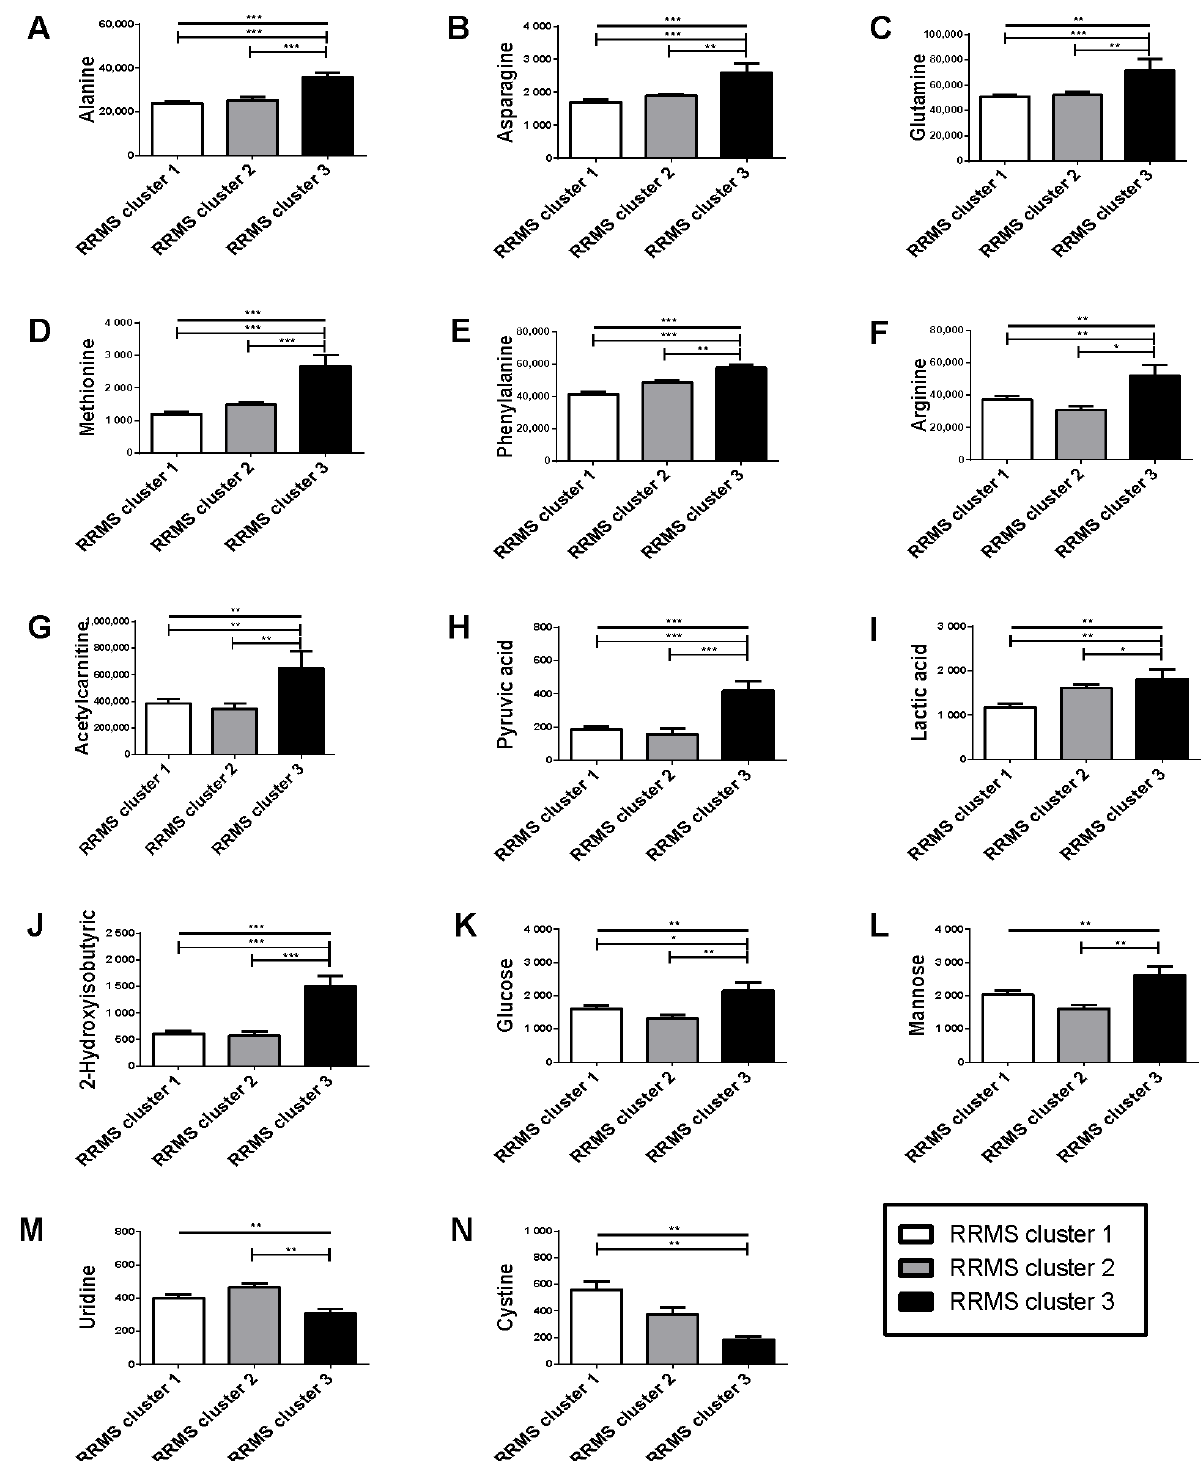
Figure 6. Variation of statistically significant metabolites in each of the studied clusters of cases with Relapsing-Remitting Multiple Sclerosis. ( A ) alanine; ( B ) asparagine; ( C ) glutamine; ( D ) methionine; ( E ) phenylalanine; ( F ) arginine; ( G ) acetylcarnitine; ( H ) pyruvic acid; ( I ) lactic acid; ( J ) 2-Hydroxyisobutyric; ( K ) glucose; ( L ) mannose; ( M ) uridine; ( N ) cystine. Bars ± error bars indicate mean ± standard error of mean. Line with open edges indicates overall comparison among the three groups. Lines with vertical edges indicate post-hoc comparisons. * p < 0.05; ** p < 0.01; *** p <